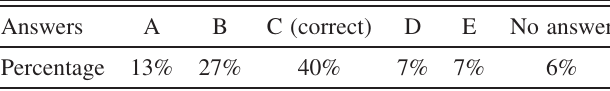
TABLE II. The choice distribution of 15 students answering the question about energy measurement outcome after traditional